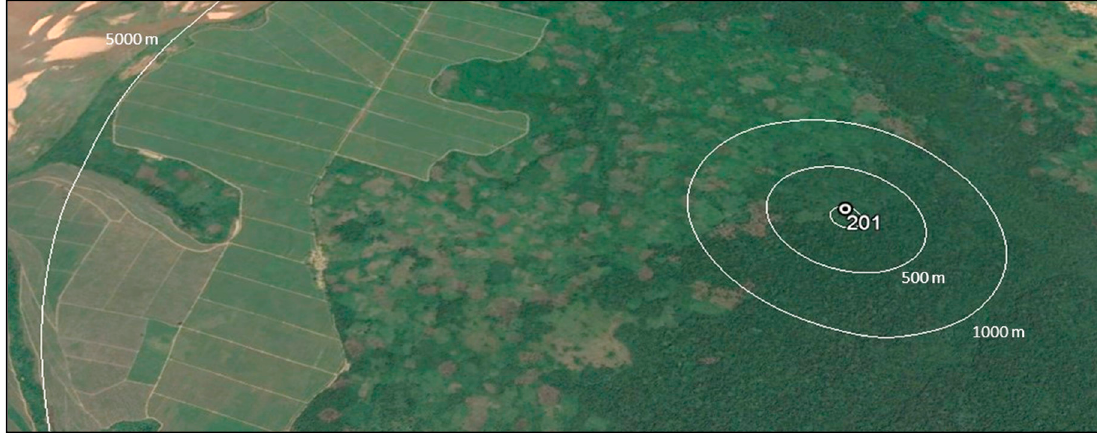
Figure 8. Point 201 (oblique view) is primary forest, with a palm oil plantation within 5 km (4°20 ′ 51.24 ″ S, 20°24 ′ 19.54 ″ E).